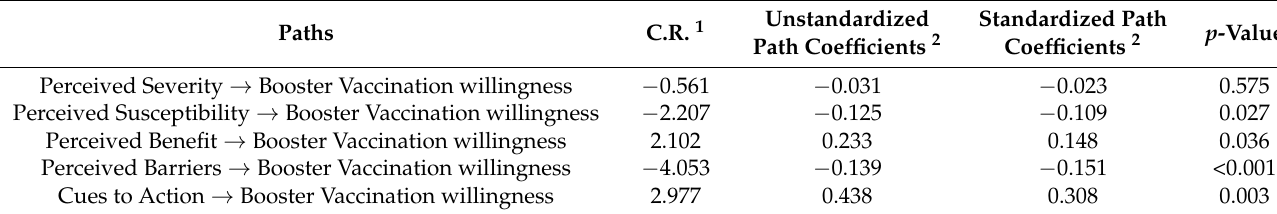
Table 6. Effect of HBM variables on public COVID-19 booster vaccination